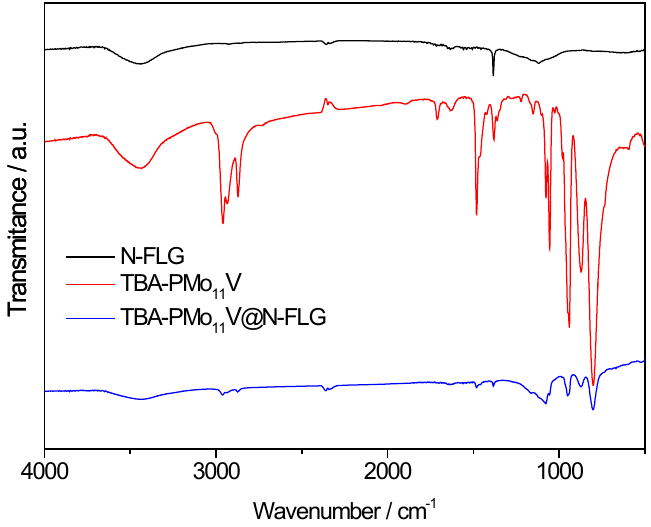
Figure 1. FTIR spectra in the range 4000–500 cm − 1 for N-FLG ( black ), PMo 11 V ( red ) and PMo 11 V@N-FLG ( blue